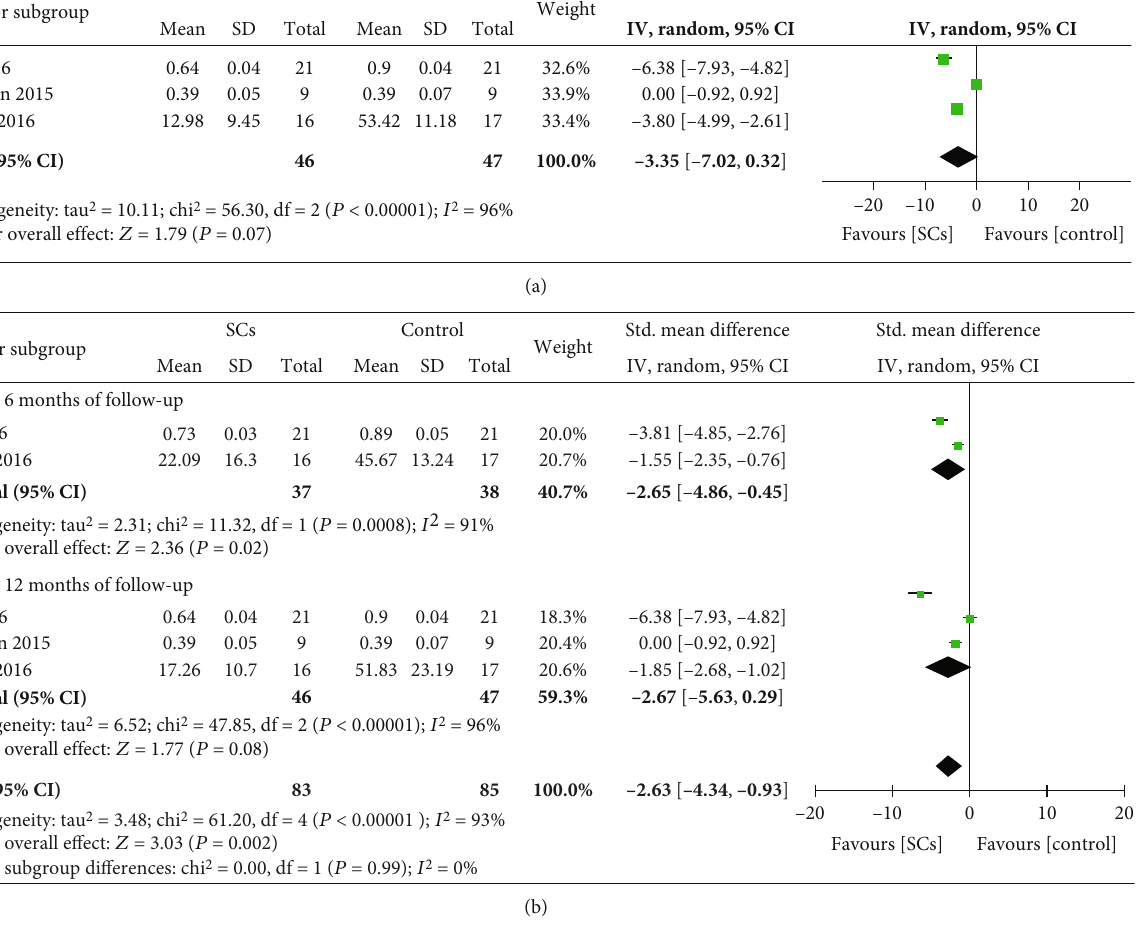
Figure 3: Insulin dosage at the longest follow-up (a). Insulin dosage at di ff erent follow-up (b)